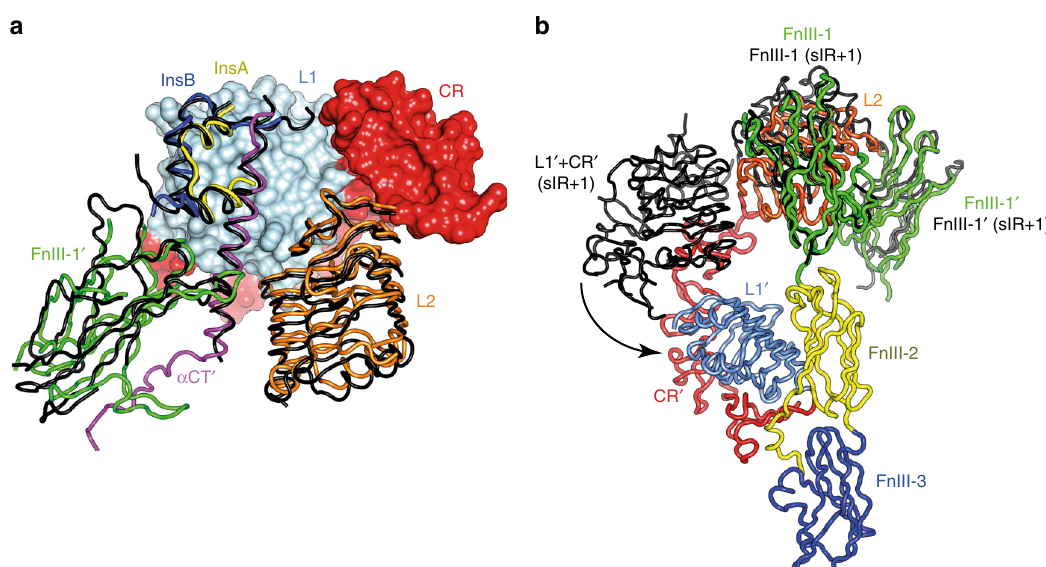
Fig. 4 Comparison of the cryo-EM structure of IR Δβ -zipInsFv with the insulin-complexed cryo-EM structures sIR + 2 and sIR + 1 7 . a Schematic illustrating the similar environments of insulin, based on an overlay of the common L1-CR modules of IR Δβ -zipInsFv and sIR + 2 (shown as surface for IR Δβ -zipInsFv and omitted for sIR + 2). Remaining domains are shown as colored coil for IR Δβ -zipInsFv and black coil for sIR + 2. b Schematic illustrating the altered disposition of the respective unliganded L1-CR modules in IR Δβ -zipInsFv and in sIR + 1. Overlay is based on common FnIII-1/FnIII-1 ′ modules. Domains are shown as colored coil for IR Δβ -zipInsFv and black coil for sIR +